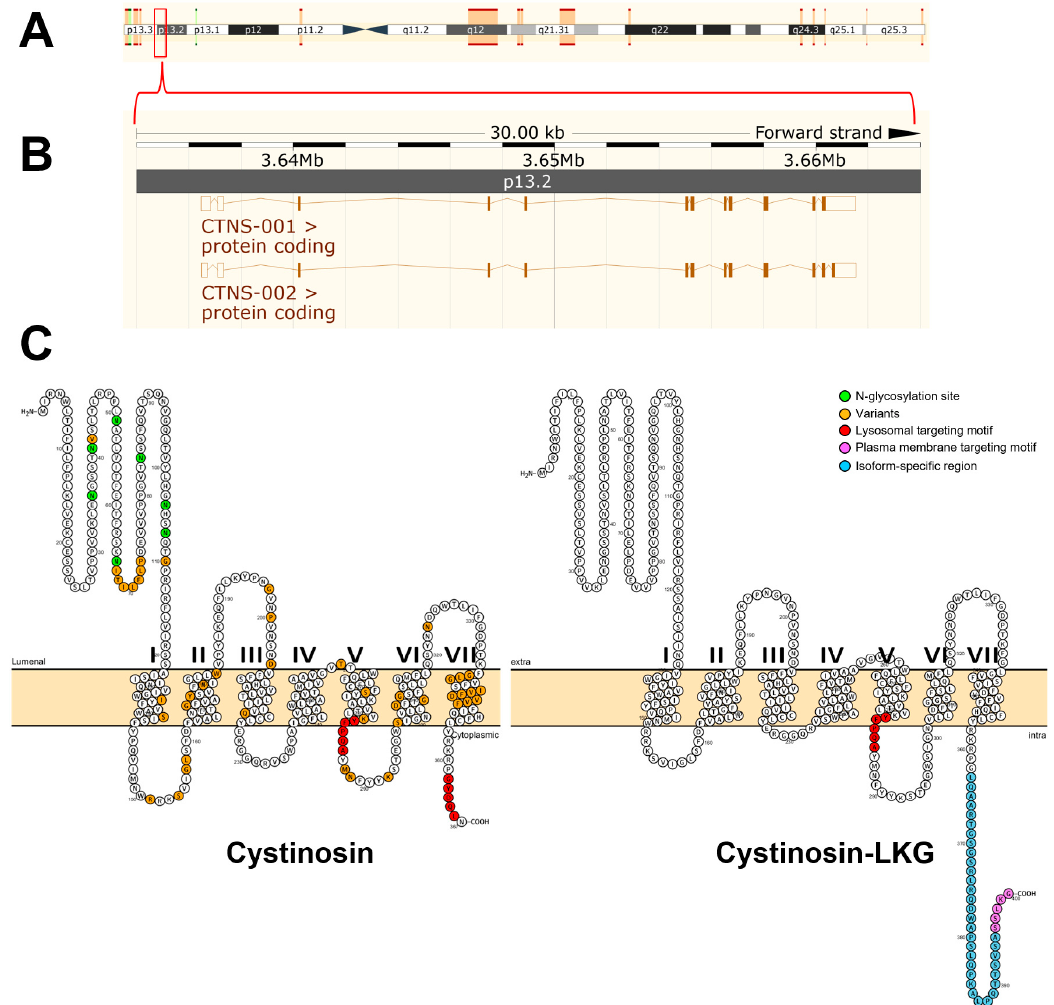
Figure 1. The CTNS gene and the predicted molecular structure of cystinosin. The CTNS gene was mapped to the short arm of chromosome 17 (17p13) using linkage analysis ( A ). The gene contains 12 exons distributed across approximately 23 kb of genomic DNA ( B ). The first two of which are noncoding. The remaining 10 exons encode the 367 amino acids that make up cystinosin. Using the open-source tool for visualization of proteoforms, PROTTER [20], the two cystinosin isoforms were visualized ( C ). The canonical cystinosin isoform (UniProt #O60931-1) is predicted to contain seven transmembrane domains, a 128 amino acid N-terminal region bearing seven potential N -glycosylation sites (green-colored circles), a non-cleavable signal peptide, and a 10 amino acid cytosolic C-terminal tail. Targeting of cystinosin to the lysosomes requires a signal peptide. At least two lysosome-targeting motifs have been identified. The cytosolic C-terminal domain of cystinosin resides a tyrosine-based GYDQL motif (red-colored circles, residue 362–366). The second motif, termed YFPQA (red-colored circles, residues 281–285), was mapped to the third predicted cytoplasmic loop. Some of the identified mutations are shown (yellow circles). These mutations include missense mutations, in-frame deletions, and insertions which account for different clinical variants of cystinosis. An alternative splicing of the exon 12 that removes the GYDQL motif generates the second isoform of cystinosin (UniProt #O60931-2). This second cystinosin isoform is termed cystinosin-LKG based on its last three amino acids. Cystinosin-LKG differs from the canonical isoform in the carboxy-terminal sequence (cyan-colored circles) and its proposed motif critical for the protein sorting to the plasma membrane, SSLKG (purple-colored circles). Both ( A , B ) were generated using the open-source visualization tool, Ensembl 2018 [21].